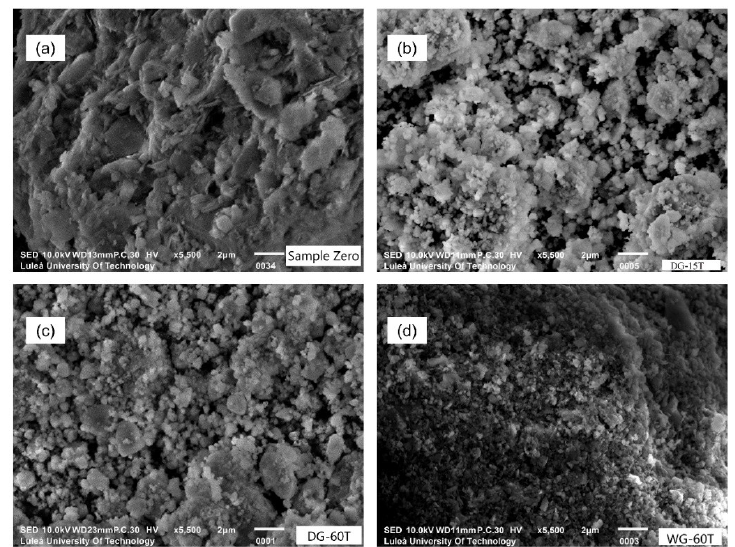
Figure 7. SEM-SE micrographs of processed materials ( a ) sample S0; ( b ) DG-15T; ( c ) DG-60T; ( d ) WG-60T.